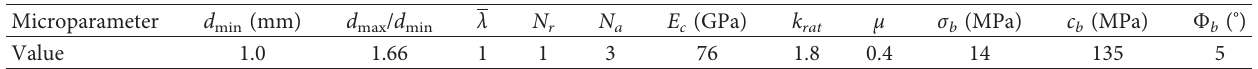
Table 7: Microparameters of the FJM after